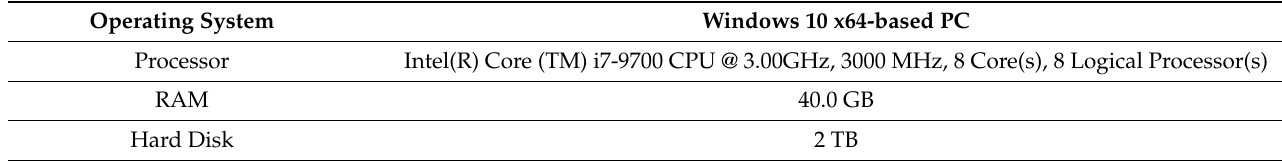
Table 5. System configuration.